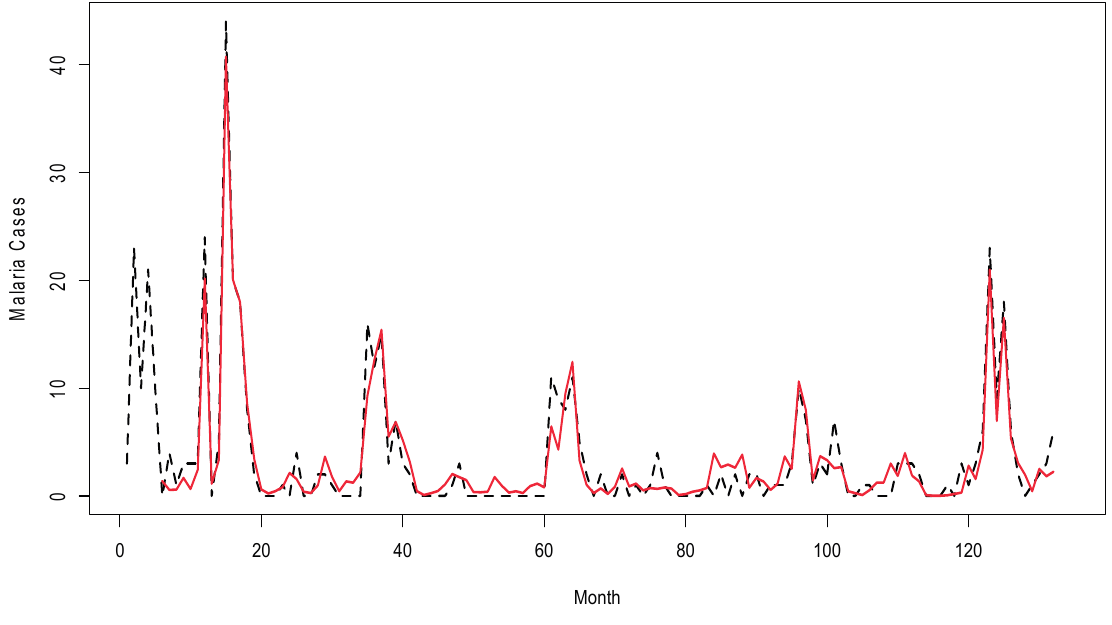
Figure 4. Reported malaria cases (black dotted line) and fitted cases (red line) generated by model for the years